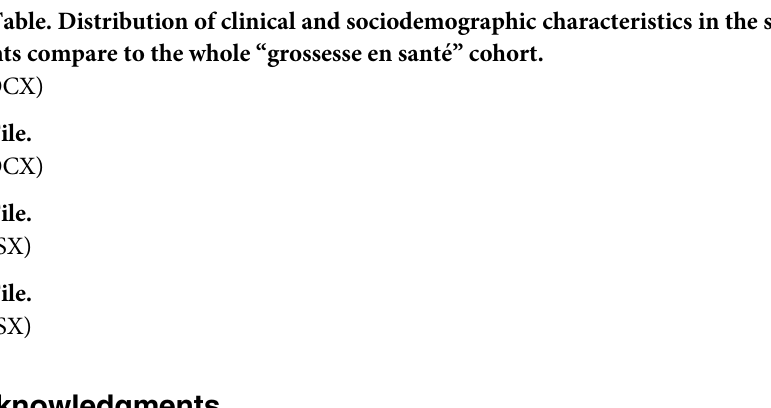
S1 Table. Distribution of clinical and sociodemographic characteristics in the study partic- ipants compare to the whole “grossesse en sante´”